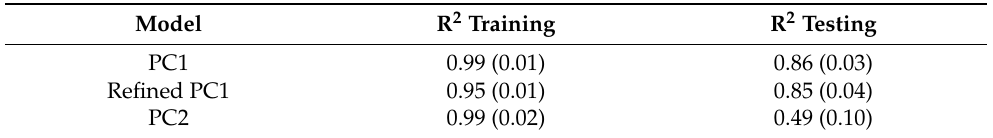
Table 2. Model performance for training and testing data for each of the modeled datasets, with standard deviations in parentheses.